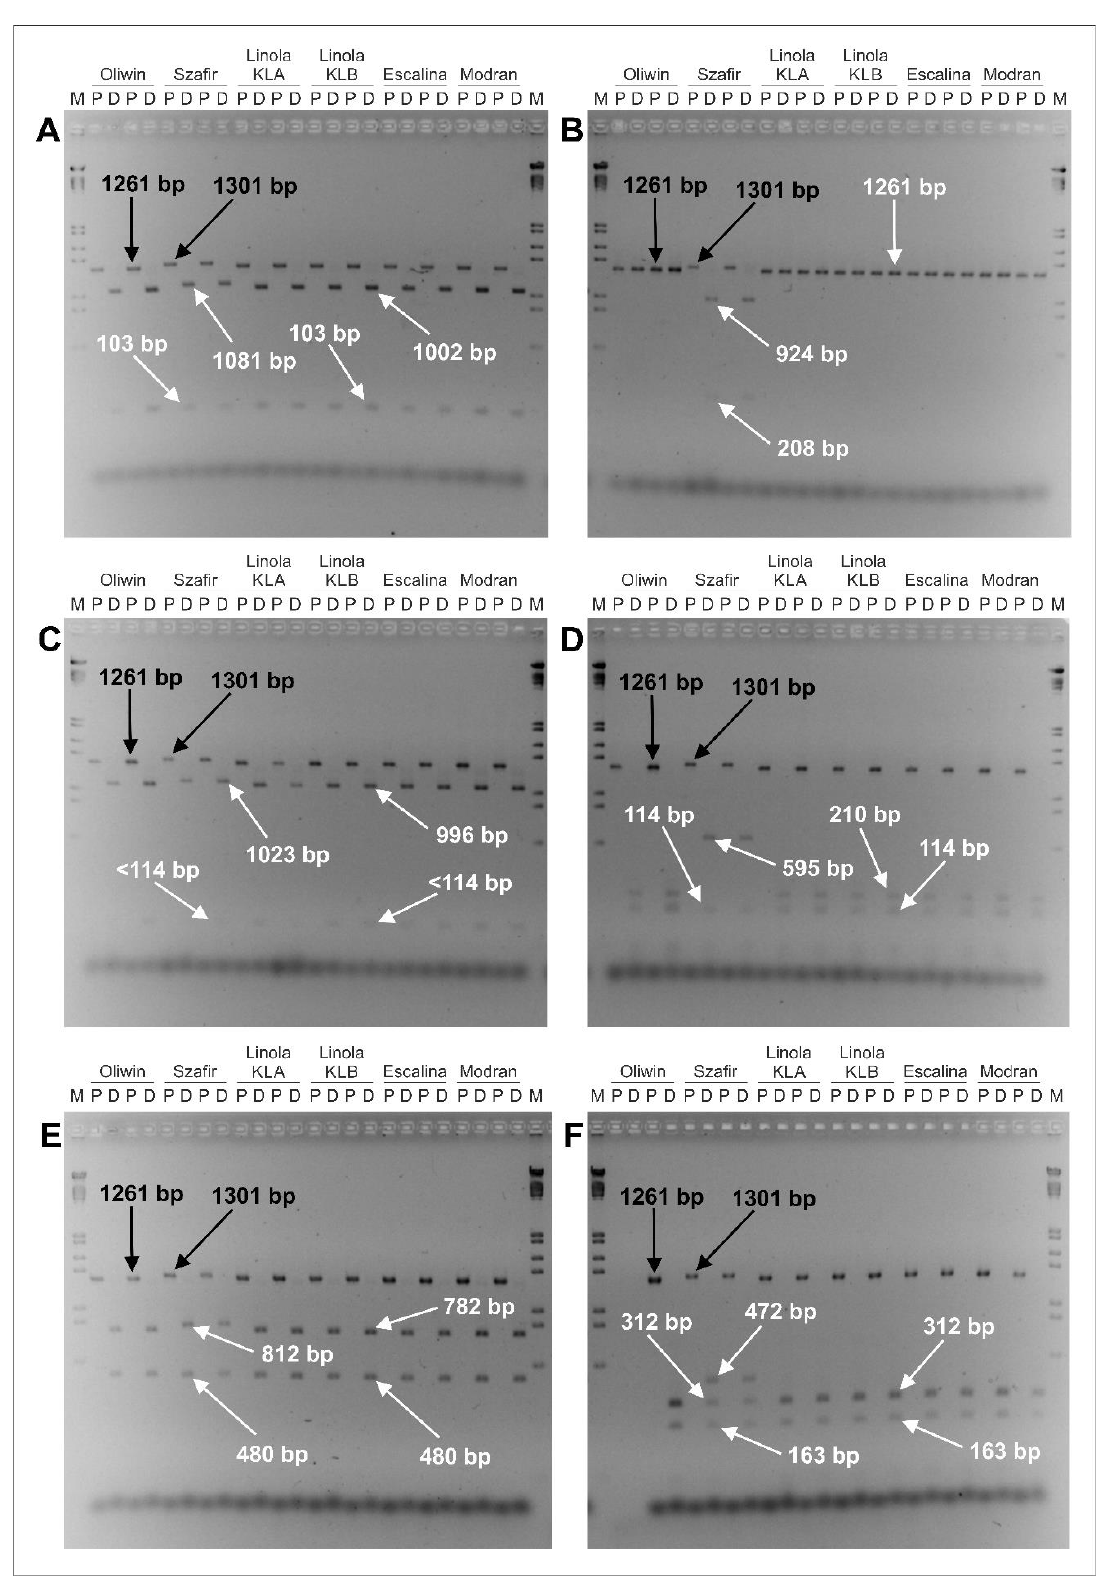
Figure 3. Results of analyses for twelve flax DNA samples using six CAPS markers obtained with the described primers and six various restriction enzymes. ( A ) Pvu I, ( B ) Hin dIII, ( C ) Bsu RI, ( D ) Hin 1II, ( E ) Vsp I, ( F ) Tru 1I. P — undigested (control) sample, D — digested sample, M — size marker; black and white arrows indicate obtained bands from the undigested (control) and digested samples, respectively.